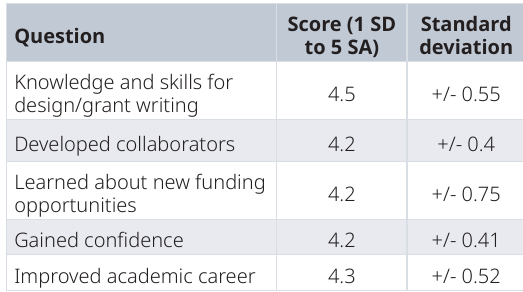
Table 3. Results of satisfaction